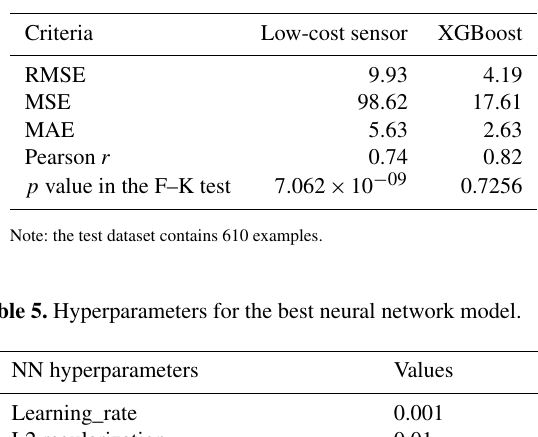
Table 6. Calibration results by the neural network using the test dataset.